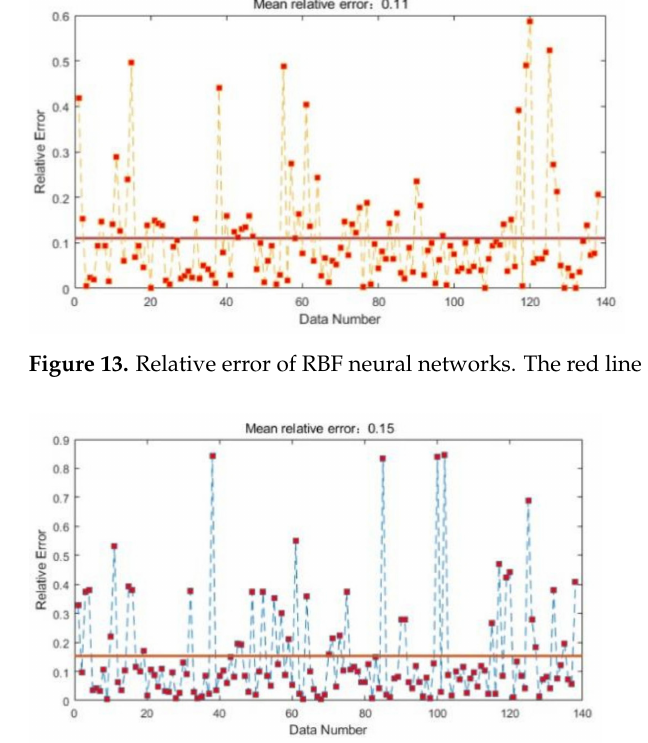
Figure 14. Relative error of BP neural networks. The red line represents the mean relative